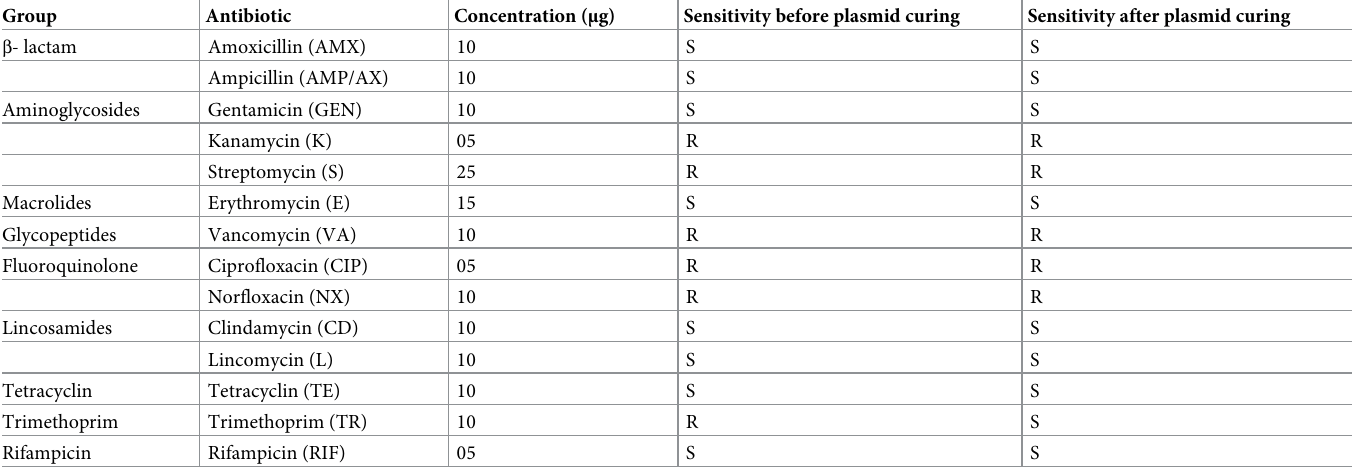
Table 3. Antibiotic sensitivity of P . pentosaceus OBK05 using different antibiotic discs before and after plasmid curing.